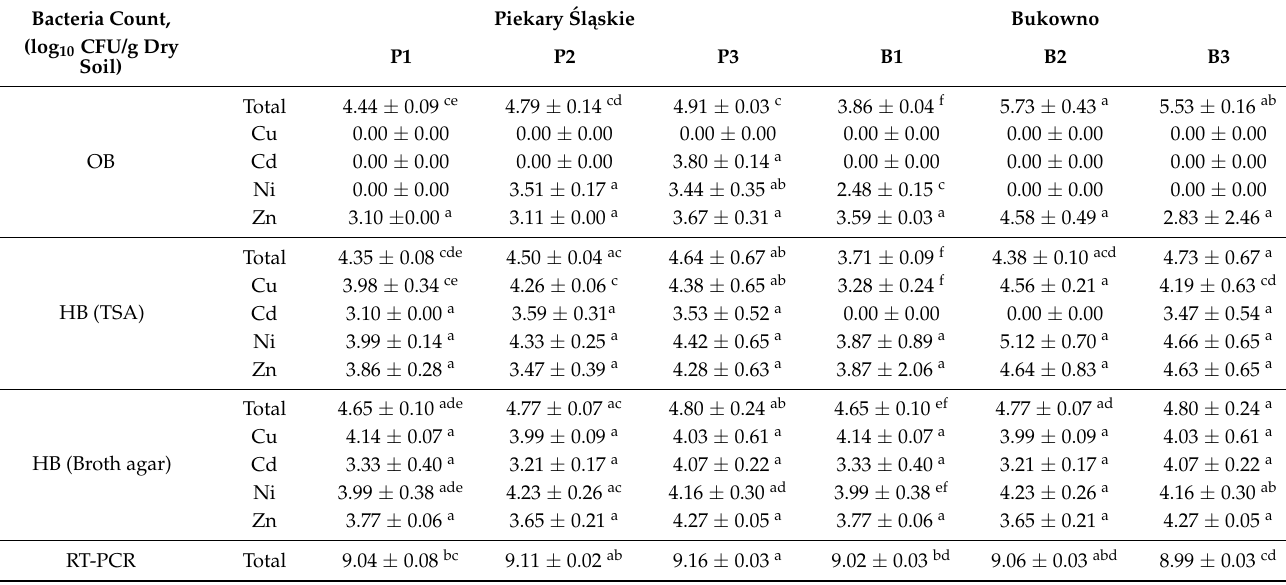
Table 2. Metallotolerant bacteria enumeration in soil